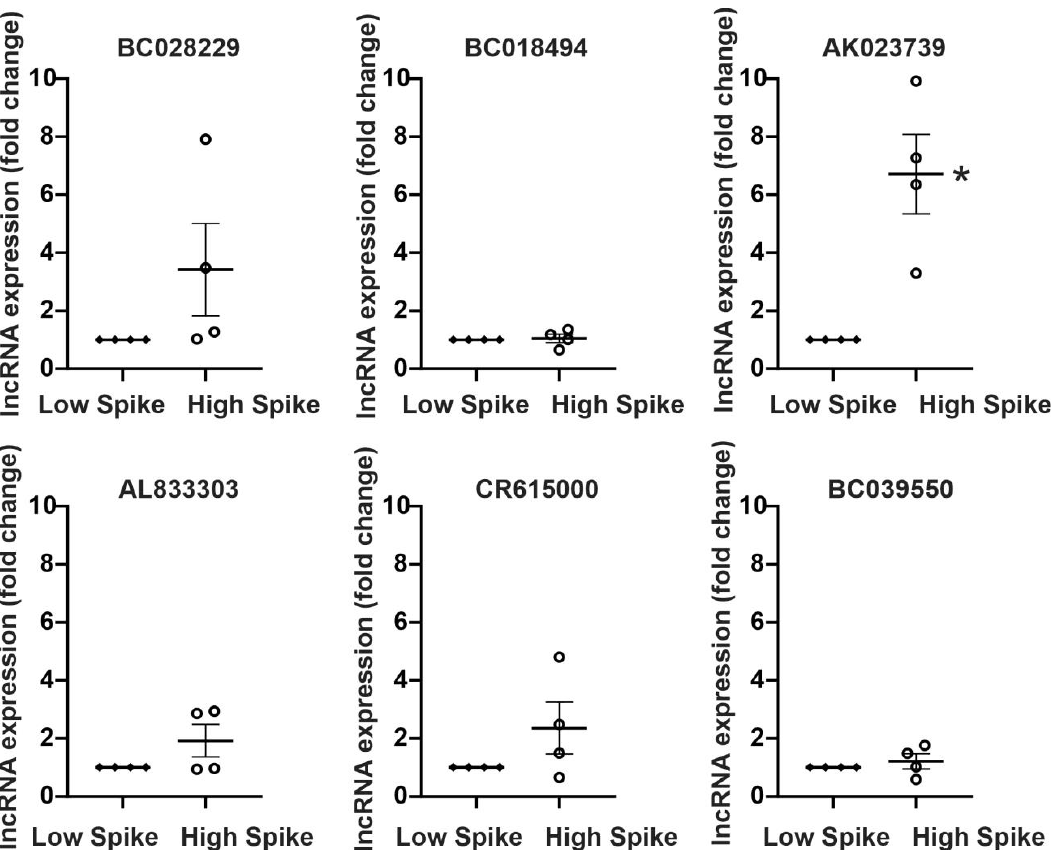
Figure 2. qPCR of human epileptic neocortical tissue samples confirms the differential expression of lncRNAs. Within each patient, brain regions that were previously identified as having high epileptic signaling (High Spike) or low epileptic signaling (Low Spike), were compared. Five of the six lncRNAs demonstrated increased expression in areas of high epileptic spiking activity, including a 3.7-fold increase in BC028229, a seven-fold increase in AK023739 (* p < 0.05, one-sample t -test, n = 4), a two-fold increase in AL83303, a three-fold increase in CR615000, and a 1.2-fold increase in BC039550. No change in expression was observed for the lncRNA